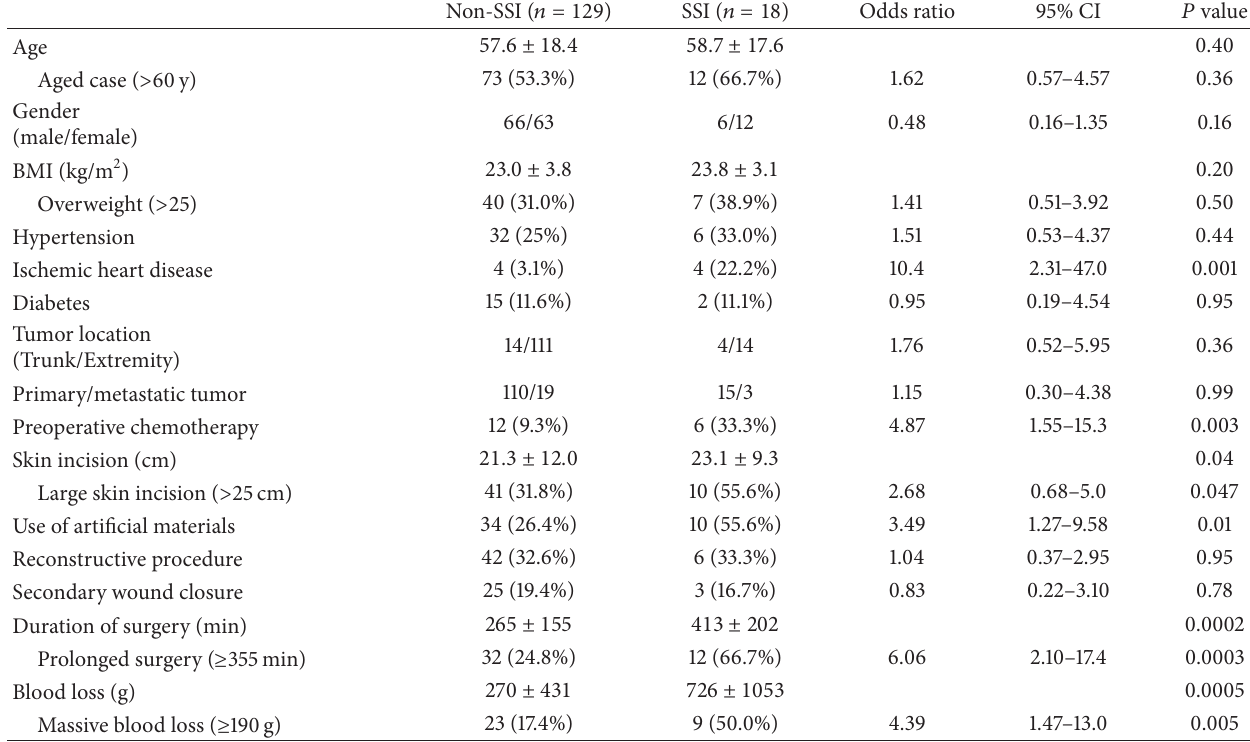
Table 2: Analysis of risk factors for surgical site infection in malignant bone and soft tissue